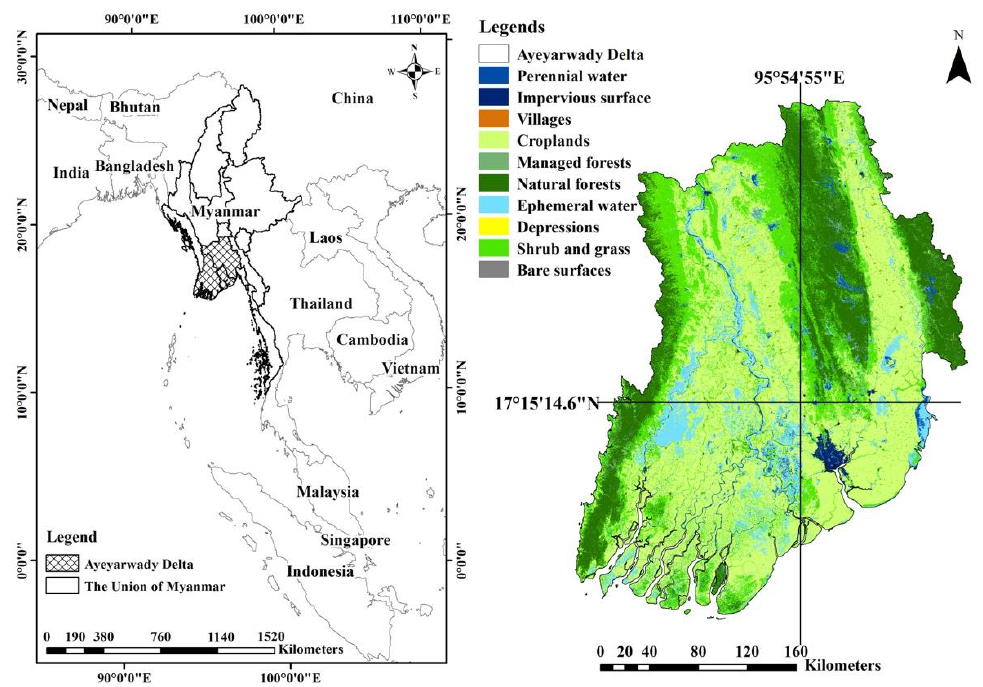
Figure 1. Land use and land cover within the study area in Ayeyarwady Delta, the Union of Myan-